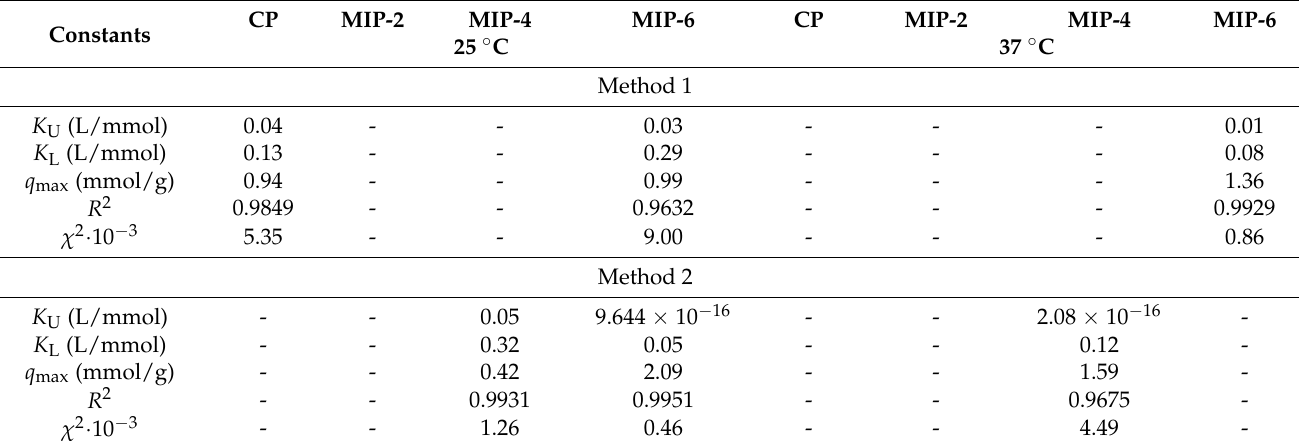
Table 5. Sorption constants calculated using the B.E.T. model isotherm by the nonlinear regression method (Method 1 and Method